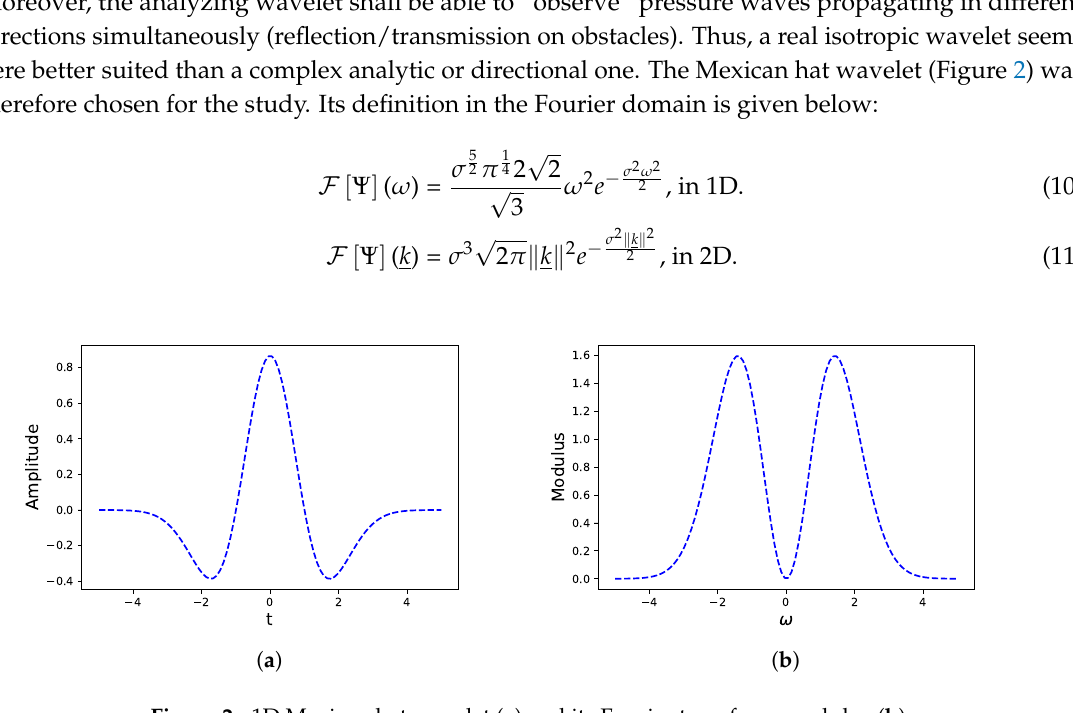
Figure 2. 1D Mexican hat wavelet ( a ) and its Fourier transform modulus ( b ).